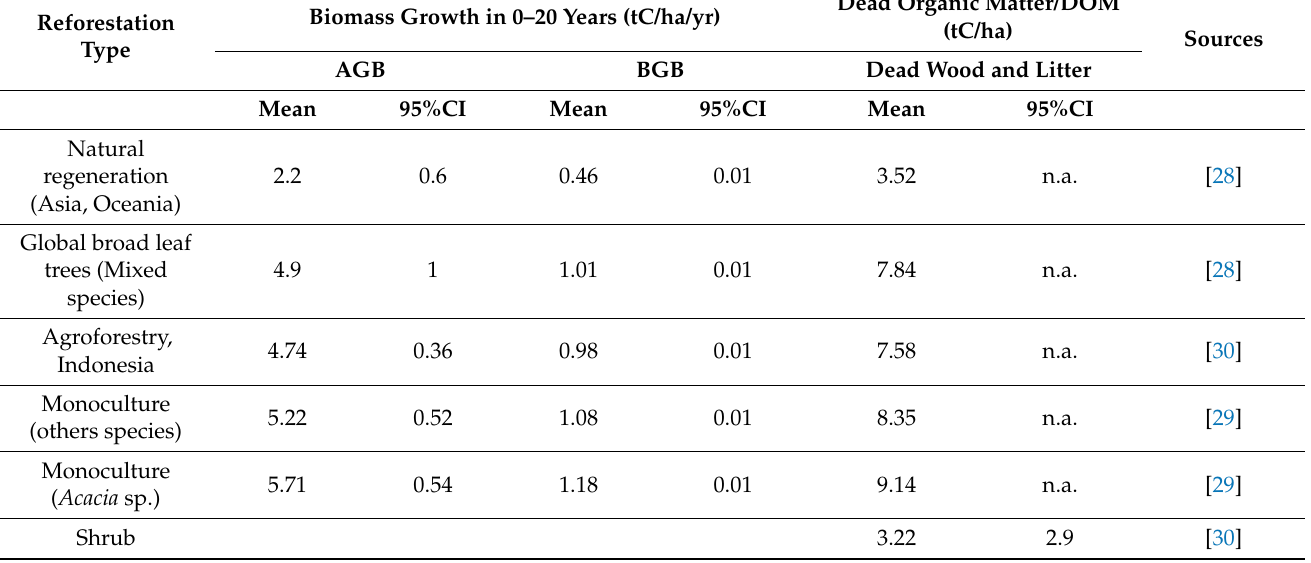
Table 1. Annual biomass growth and dead organic matter accumulation value by reforestation types used in this